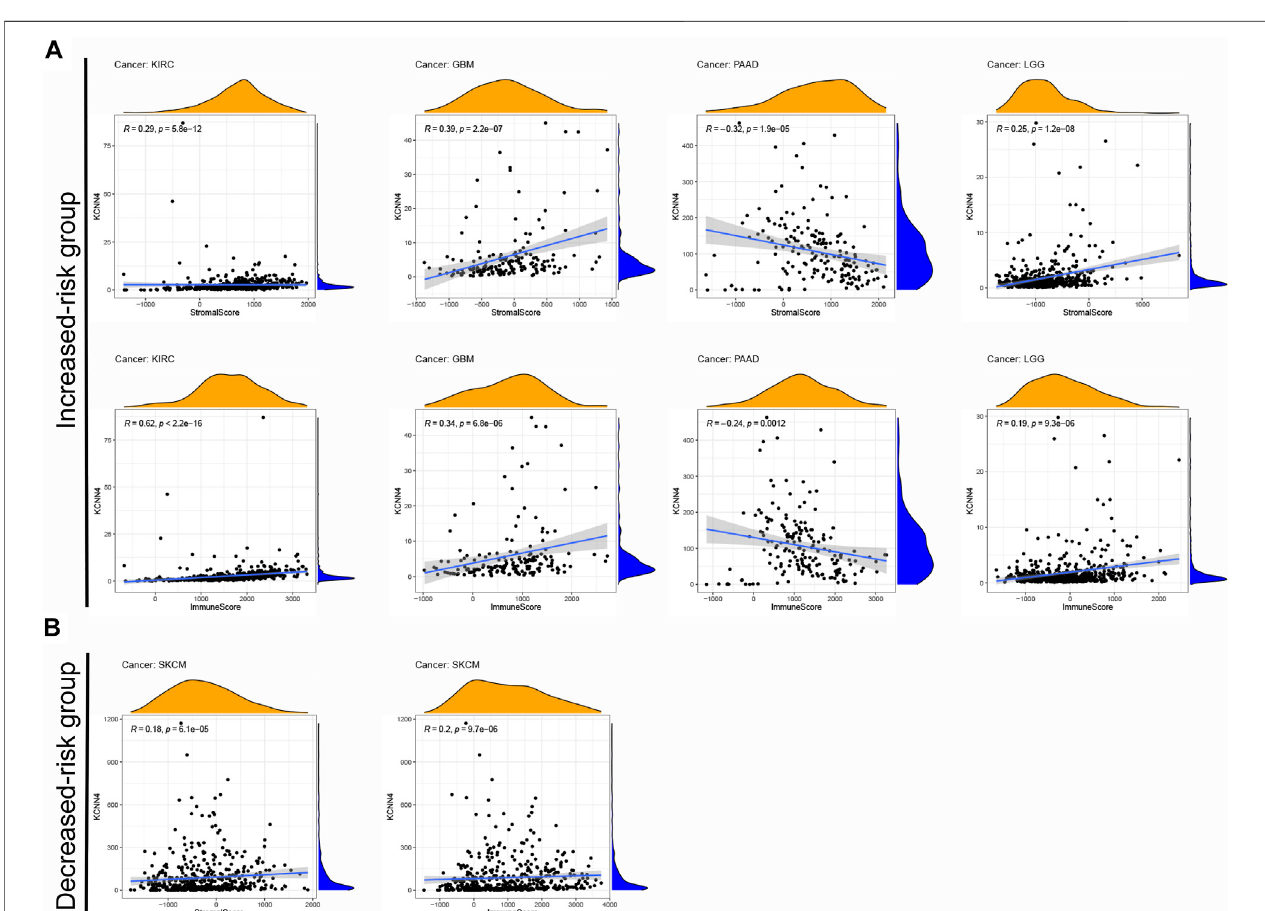
FIGURE 8 | Correlation between KCNN4 expression and different components of TME. (A) Correlation between KCNN4 expression and different components of the increased-risk group. (B) Correlation between KCNN4 expression and various components of the decreased-risk group.